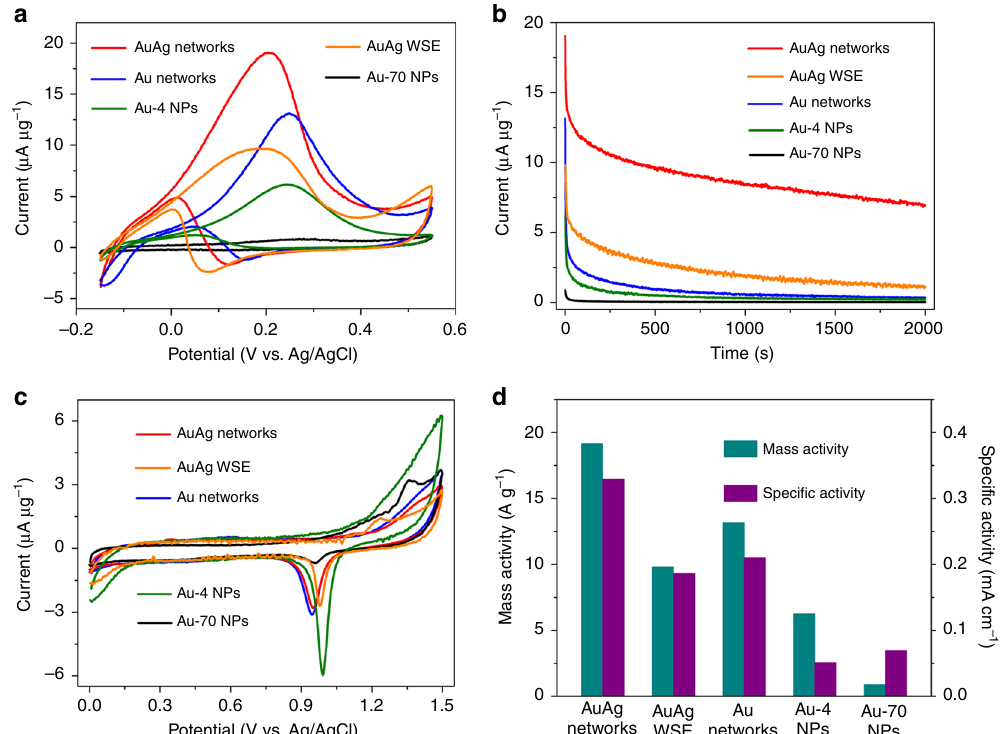
Fig. 5 The electrochemical performance. a Cyclic voltammograms of the electro-methanol oxidation, b chronamperograms, c oxide stripping curves, and d histograms of the mass activity and speci fi c activity of the AuAg networks, Au networks, Au-4 NPs, and Au-70 NPs. The cyclic voltammograms were performed in 0.5 M KOH and 2 M CH 3 OH at a scan rate of 10mVs − 1 . The oxide stripping was measured in a 0.5 M H 2 SO 4 solution at a scan rate of 10mVs −